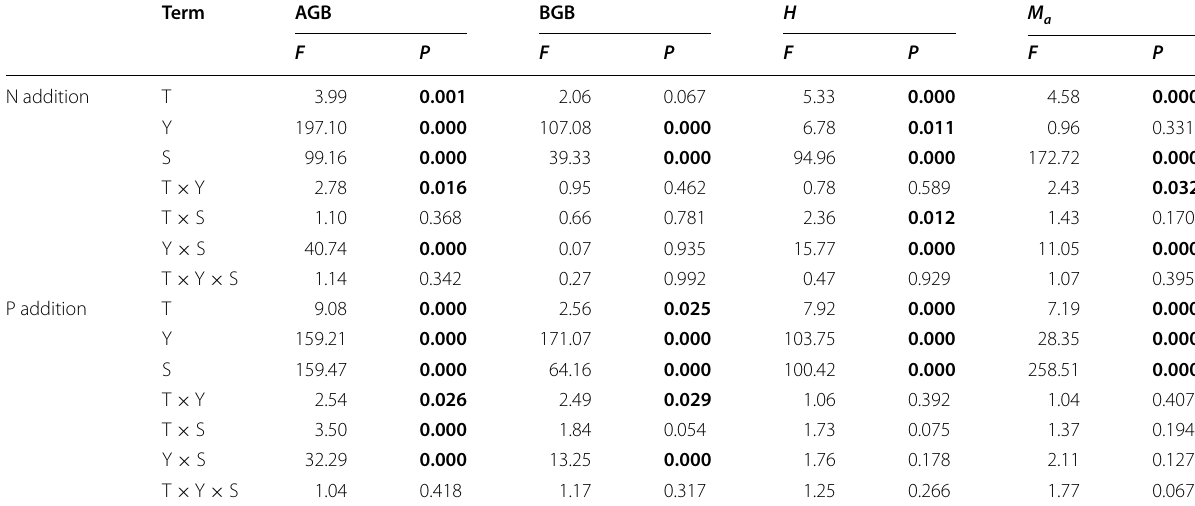
Table 2 ANOVA results for the effects of treatment (T), steppe type (S), and year (Y) on community biomass and diversity in northern China